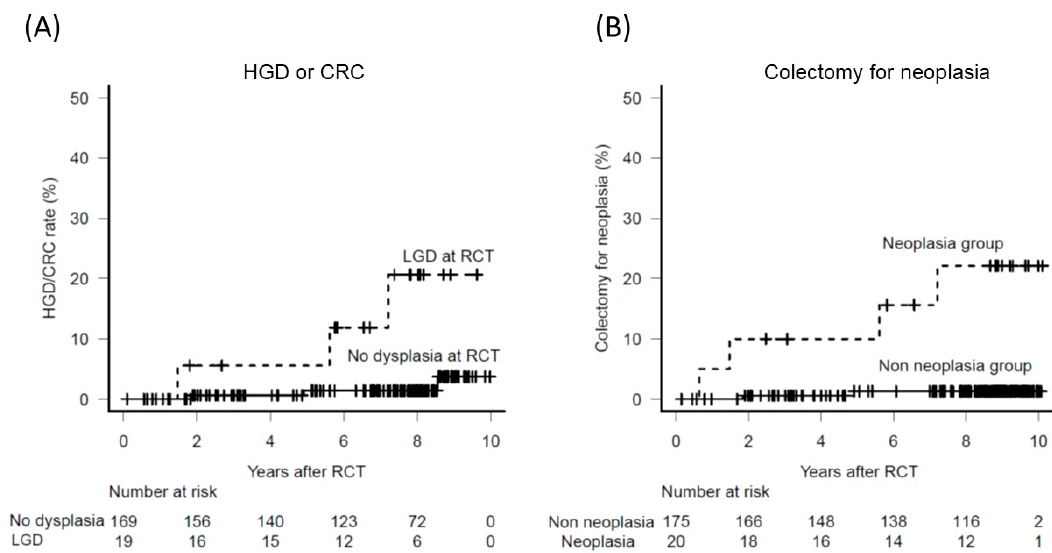
Figure 3. (A ) The cumulative rate of advanced neoplasia was significantly higher than in the non- neoplasia group (hazard ratio 10.0, 95% CI: 2.0–49.7; p = 0.005). ( B ) The cumulative rate of colectomy